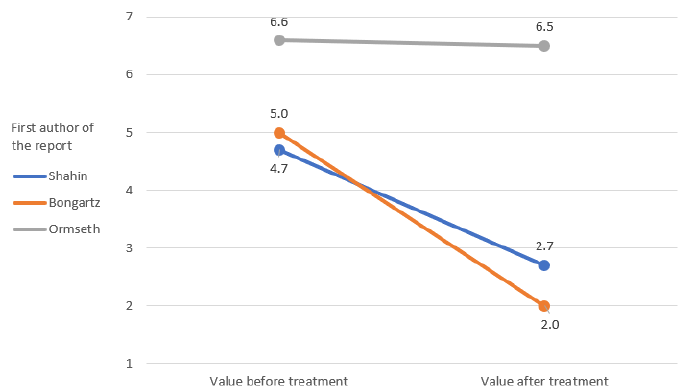
Figure 3. Initial and final values of swollen joint count (SJC).